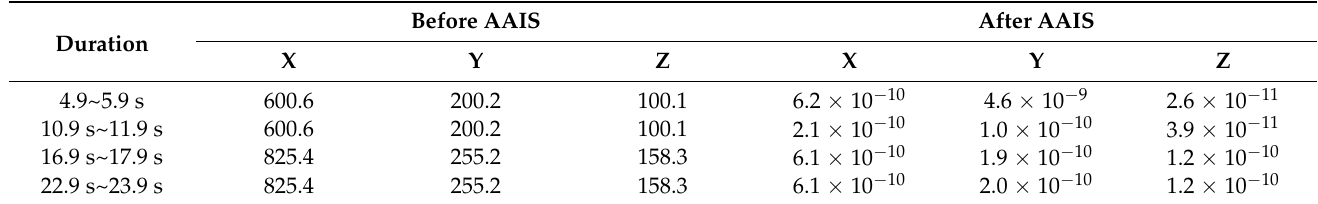
Table 4. The standard deviation (nT) for the dynamic